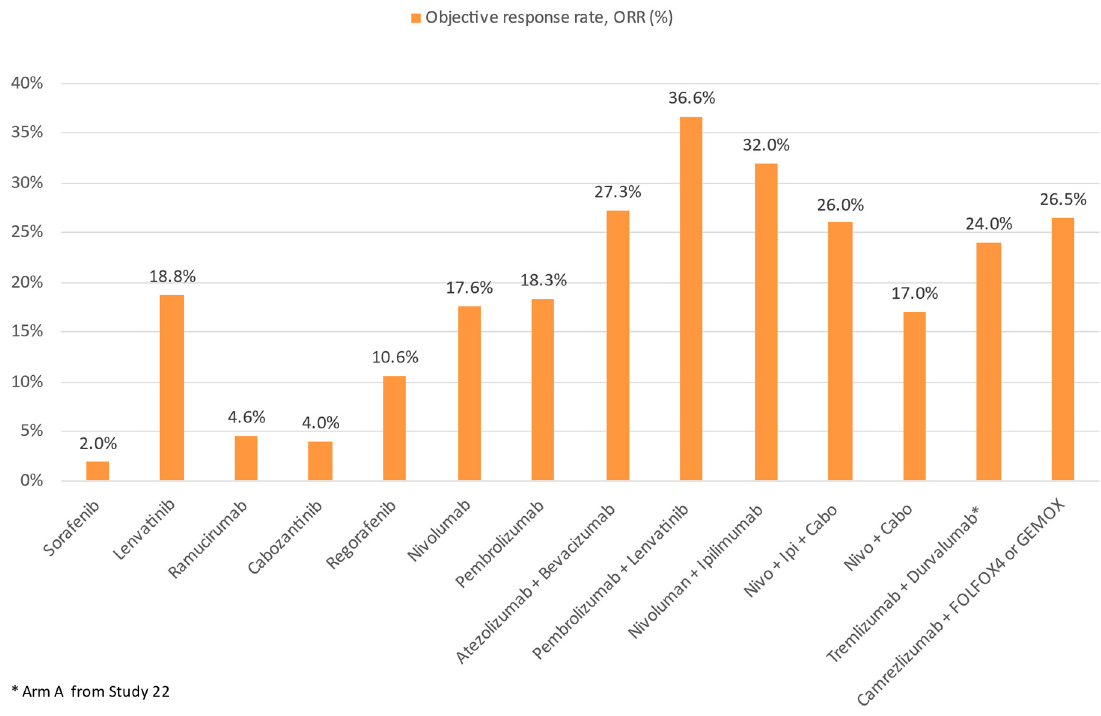
Figure 6. Comparison of ORR of ICI and TKI monotherapy or combination therapy with other treatment modalities in advanced HCC.